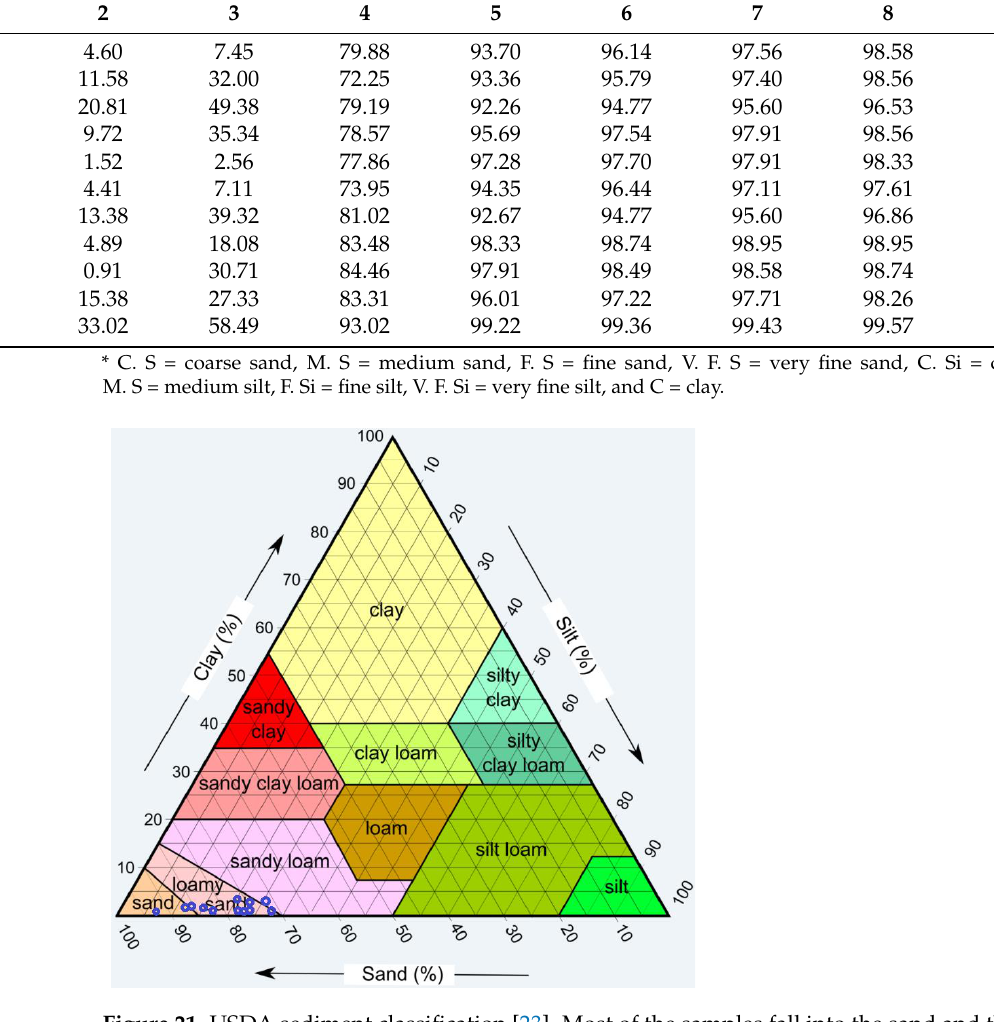
Figure 22. Grain size cumulative frequency curves showing the range of grain size distribution of the studied samples. According to the curves in Figure 22, the primary grain size that dominated in the samples is the size between the sieves of the (0.075) mm and (0.125) mm sizes, or the Phi values of four and three, respectively, with a percentage range of 50 – 90% of the sizes. This result shows the domination of very fine sand in most of the samples. The samples showed a range of sorting, from poorly to moderately well-sorted samples. The Crocker and Tem- burong Formation samples all showed poor sorting, while most of the Belait Formation samples showed a moderate sorting, reflecting the nature of the deposition of the deep marine and fluvio-marine depositional environments. The graphic skewness values showed different values between the symmetry and the positive and negative skewness (Table 4). The samples from the same outcrops of the